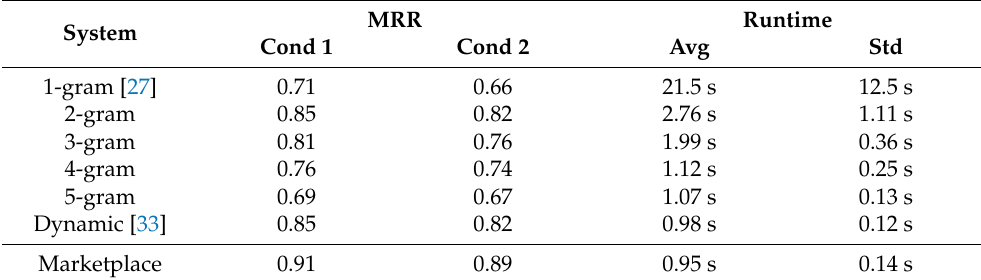
Table 1. Experimental results on the camera-based sheet music retrieval task. Condition 1 assumes that the exact same PDF is in the database, while condition 2 assumes that only alternate printed editions of the same piece exist in the